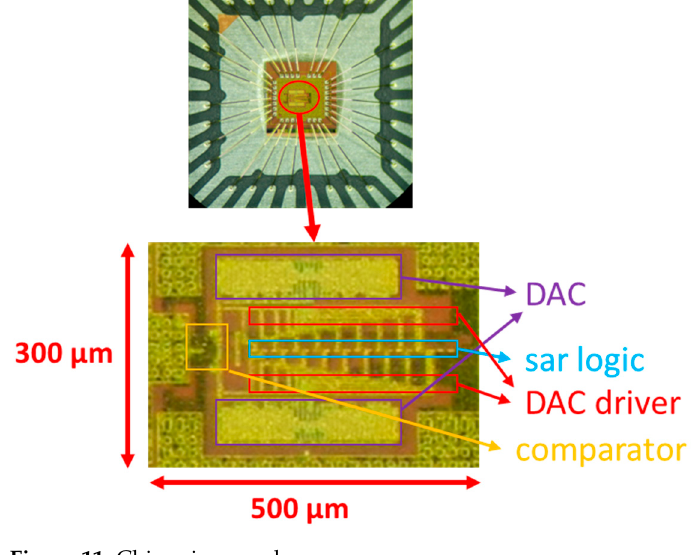
Figure 11. Chip micrograph.